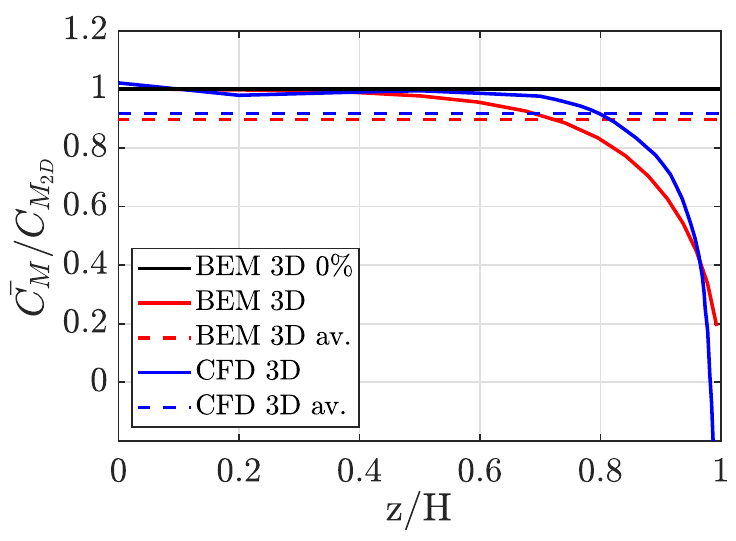
Figure 10. Average torque coefficient ¯ C M normalised by C M at midspan z/H = 0 for single-bladed H-shaped at TSR = 3.3.